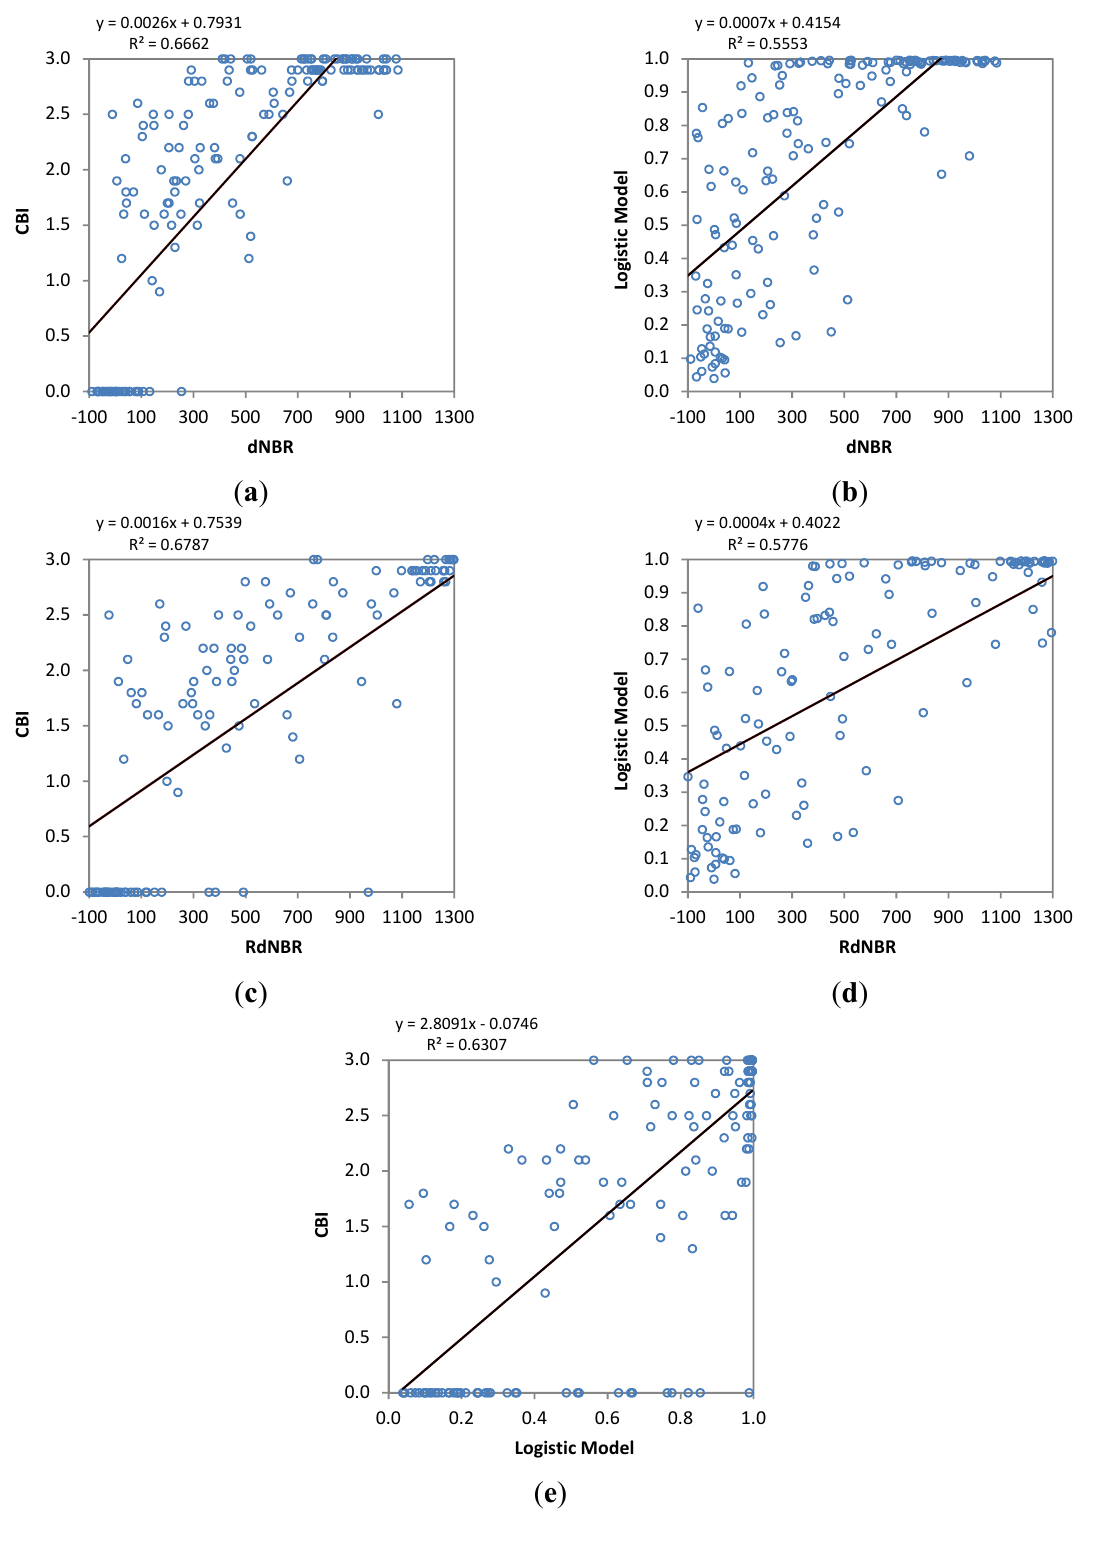
Figure 8. Scatterplots depicting the relationship between three remotely sensed severity metrics (RdNBR, dNBR, and logistic model) and CBI. The black lines represent the regression trend. The coefficient of determination (R 2 ) and the equation of the line are shown for each fit. ( a ) CBI vs. dNBR; ( b ) Logistic model vs. dNBR; ( c ) CBI vs. RdNBR; ( c ) CBI vs. RdNBR; ( e ) CBI vs. Logistic